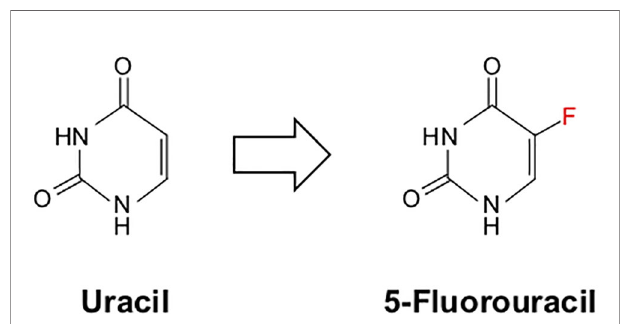
FIGURE 6 | Chemical structure of uracil and its chemical mimic 5- Fluorouracil. 5-Fluorouracil (5-FU) is a nucleoside analog identical in structure to uracil apart from a single fl uoride molecule at the 5